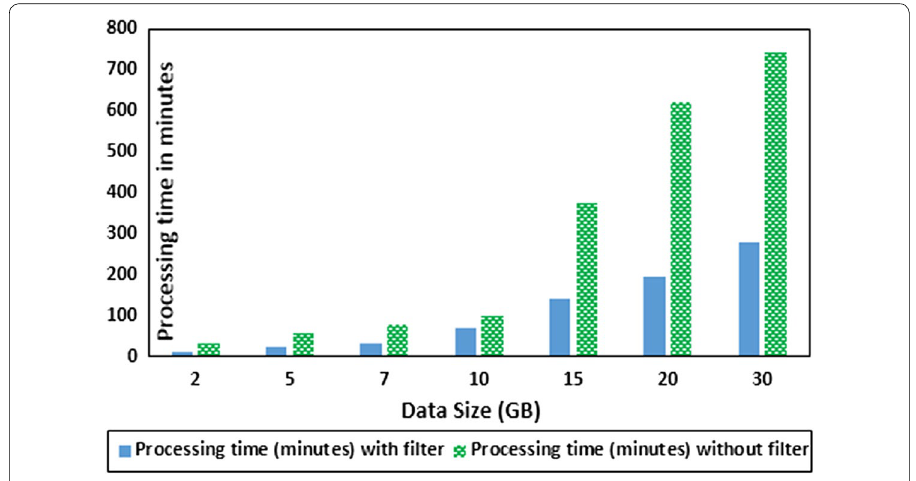
Fig. 9 Process time between filter/group and group only: comparison between using filter and without filter in the algorithm. It was proven that filter can improve the processing performance